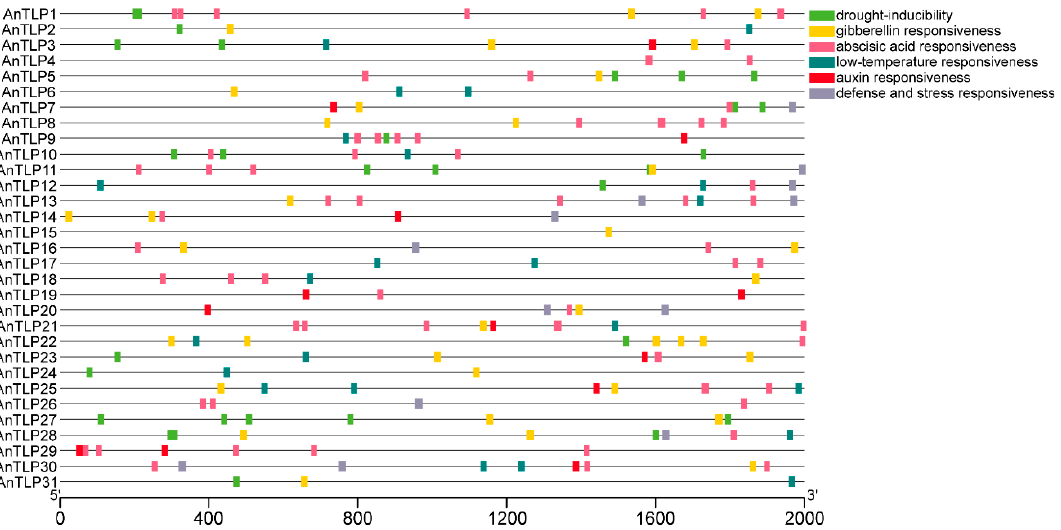
Figure 7. Distribution of the predicted cis-acting elements that were involved in abiotic stress re- sponse and hormone response in the promoter region of the AnTLP genes in A. nanus . Different color blocks represent different types of cis-acting elements. The position of the cis-acting element in the promoter region can be estimated by the scale at the bottom.